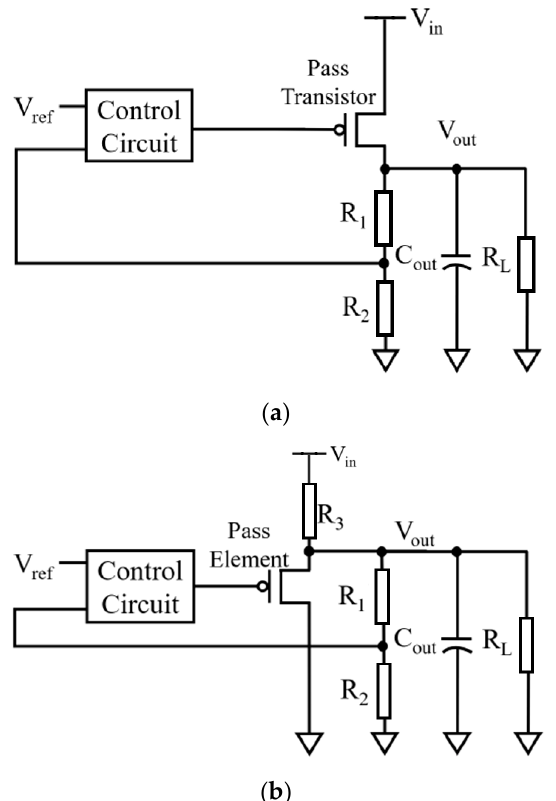
Figure 4. Block Diagram of ( a ) Series Linear Regulator ( b ) Shunt Linear Regulator.